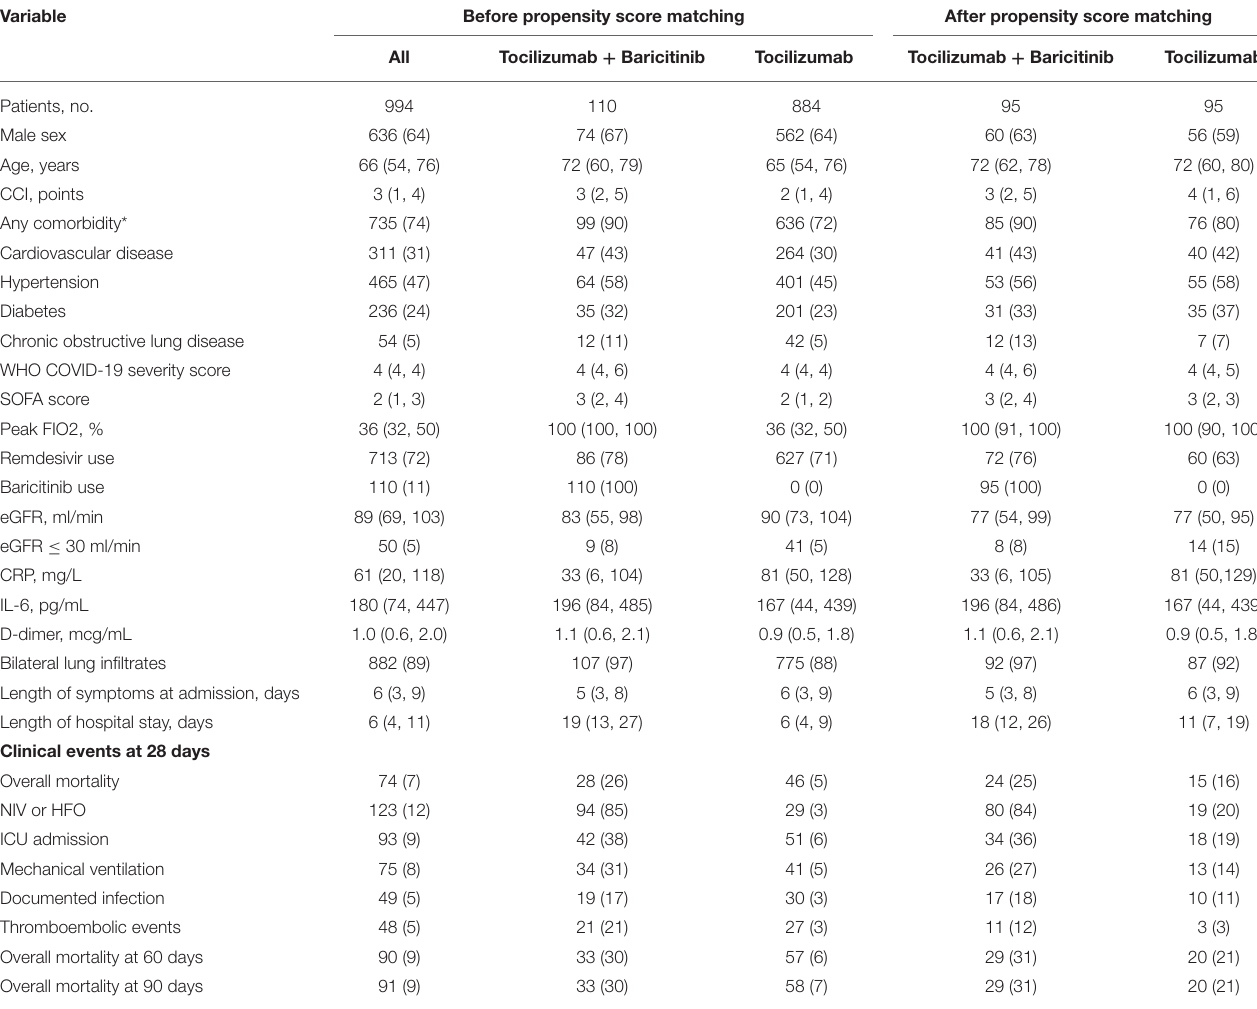
TABLE 1 | Propensity score (PS) analysis. Variable Before propensity score matching After propensity score matching All Tocilizumab + Baricitinib Tocilizumab Tocilizumab + Baricitinib Tocilizumab Patients,